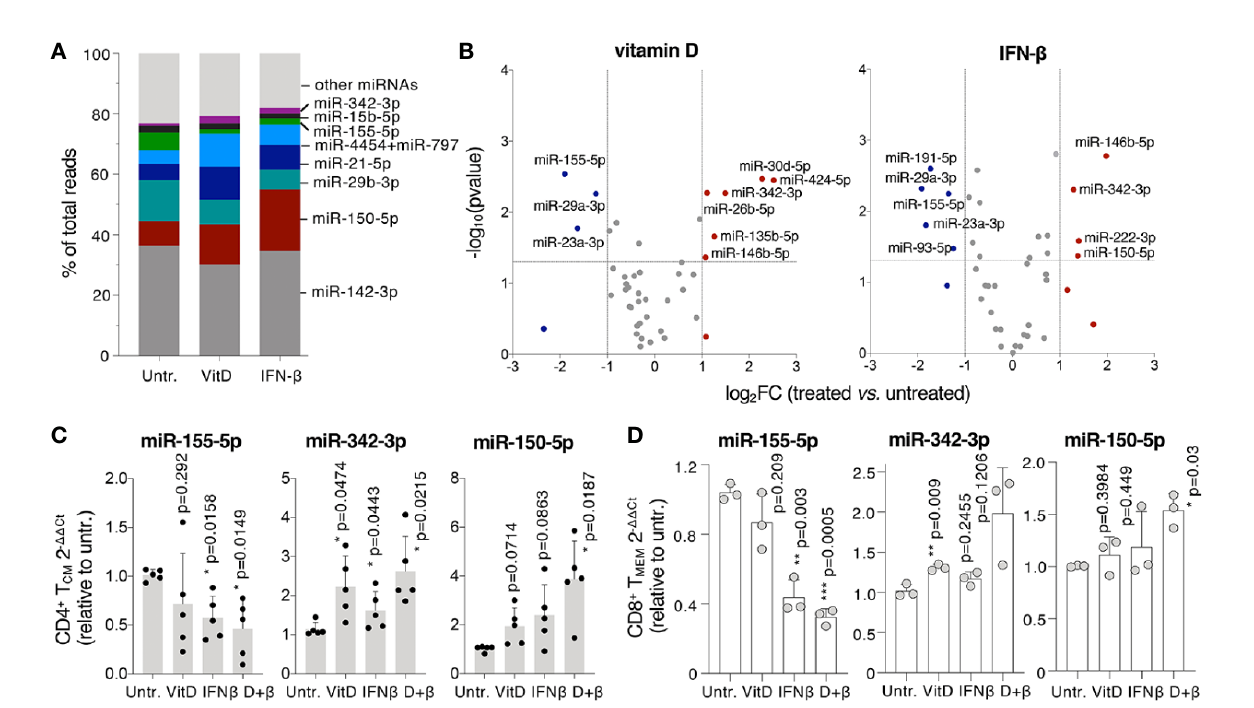
FIGURE 6 | MicroRNA (MiRNA) expression is modulated by vitamin D and IFN- b . (A) T CM cells were treated for 5 days in the presence or absence of vitamin D or IFN- b and miRNA expression was measured by Nanostring pro fi ling (n=3 donors). The percentage of normalized reads for the indicated miRNAs is shown. (B) Differentially expressed miRNAs in the same samples as (A) . (C) T CM cells were treated as in a) and the expression of selected miRNAs was measured by qRT-PCR. Each dot represents one donor (n=5). Mean ± SD; paired t-test, two-tailed, relative to untreated cells. (D) CD8 + memory T lymphocytes were activated and treated for 5 days, after which total RNA was extracted and the expression of the indicated miRNAs determined by qRT-PCR. Each dot represents one donor (n=3). Mean ± SD; paired t-test, two-tailed, relative to untreated